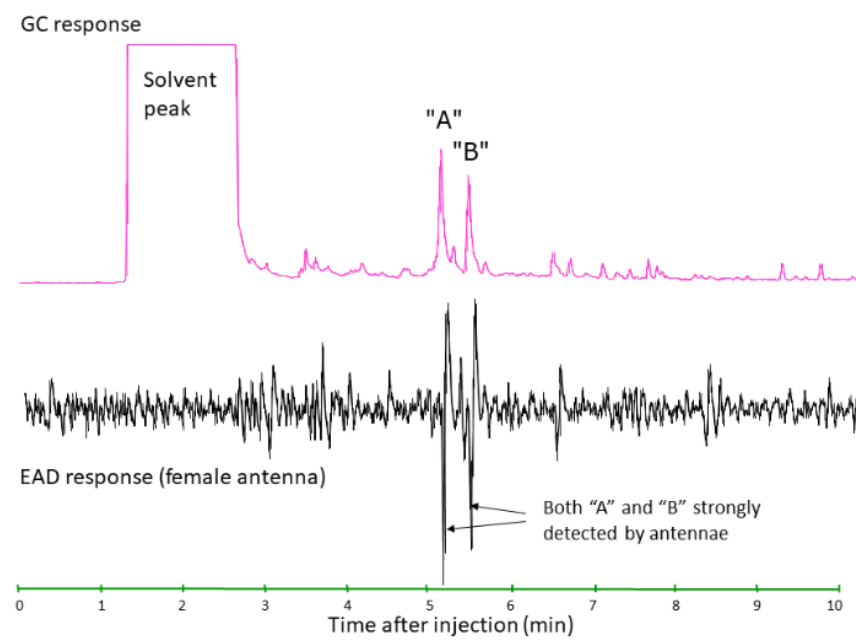
Figure 1. An example of the output of gas chromatographic-electroantennagraphic detection (GC- EAD) of volatiles from feeding D. carinulata adult males [15]. This shows the electrophysiological response of an isolated insect antenna (lower line, in black) to GC fractionated volatile compounds collected from feeding adults of D. carinulata (upper line, in pink), enabling researchers to isolate compounds that are antennally active (e.g., the D. carinulata pheromone blend, compounds A&B, (2E,4Z)-2,4-heptadienal and (2E,4Z)-2,4- heptadien-1-ol, respectively, which were fractionated from the volatiles mixture). Figure reproduced with permission from [15], copyright 2005